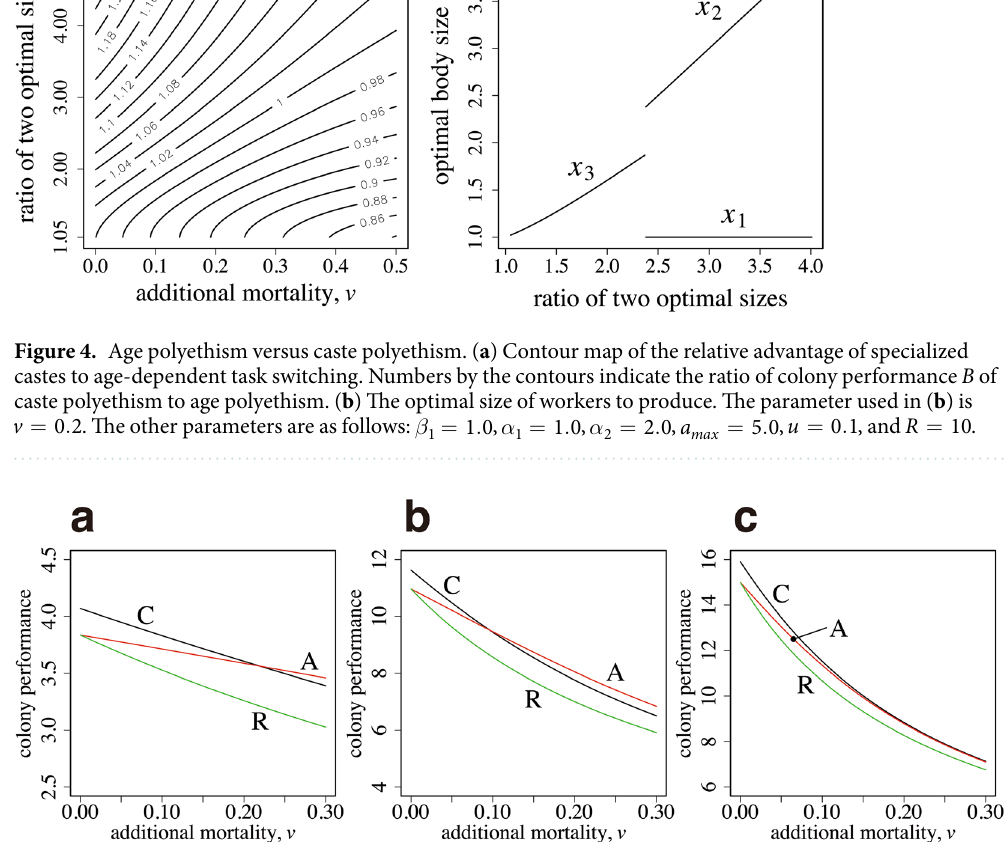
Figure 5. Effect of maximum worker age. This figure is similar to Fig. 3. The maximum worker ages are as follows: ( a ) = . a . Other parameters are the same as those in Fig.